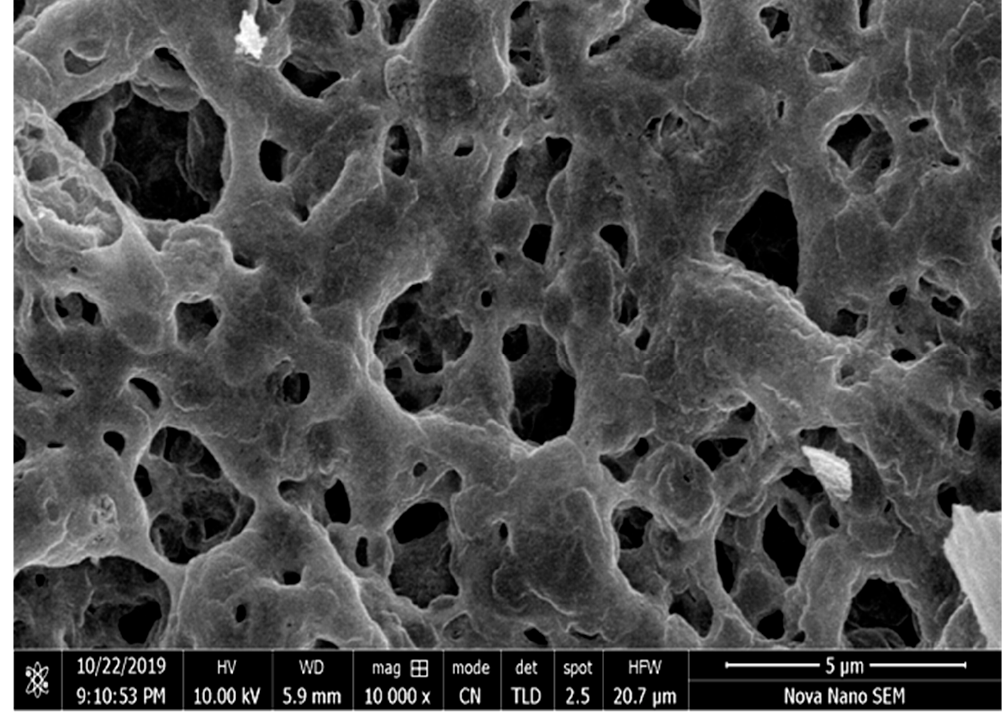
Figure 4. SEM images of Co 0.1 Al 0.03 Fe 0.17 O 0.4 at a resolution of 5 μ m.